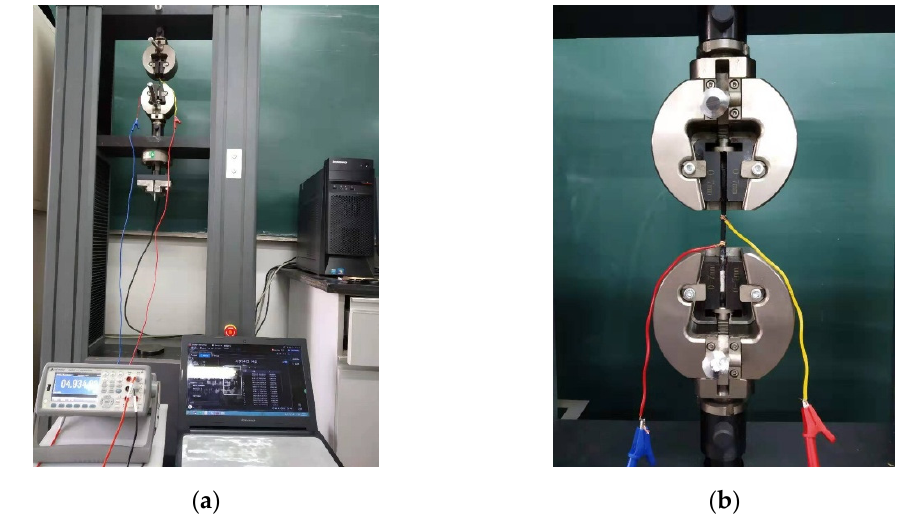
Figure 2. ( a ) Experimental setup for the piezoresistive sensing test and data measurement system, which included DMM and a data acquisition module connected to a computer, ( b ) Enlarged image showing composite sample mounted in UTM during the piezoresistive sensing test.